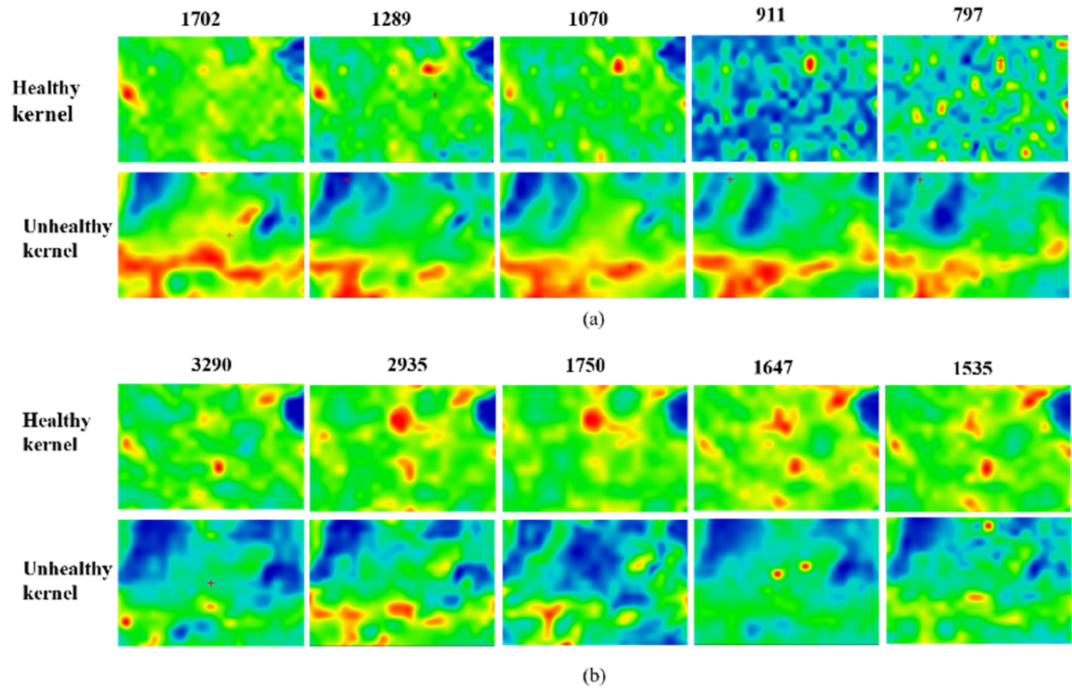
Figure 7. Infrared microscopic images for chemical distributions of trace AFB 1 accumulation ( a ) and nutrient depletion ( b ) at significant wavenumbers from healthy and unhealthy peanut